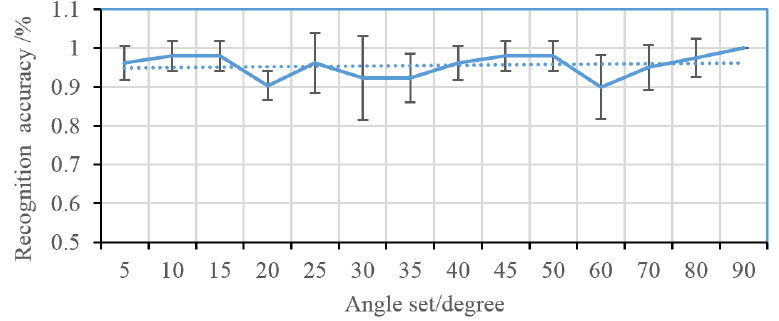
Figure 11. The curve of recognition accuracy change with set angle in preferred coding method. Error bars indicate standard